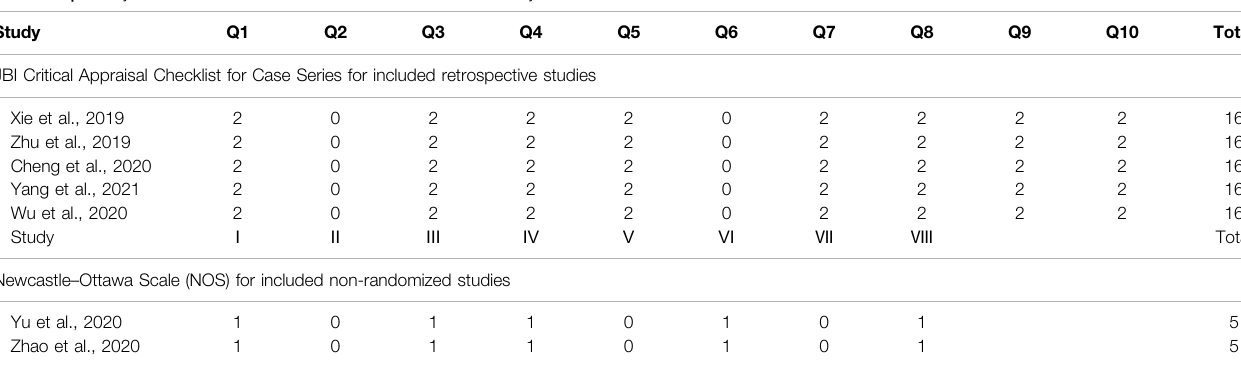
TABLE 2 | Quality assessment of the studies included in the